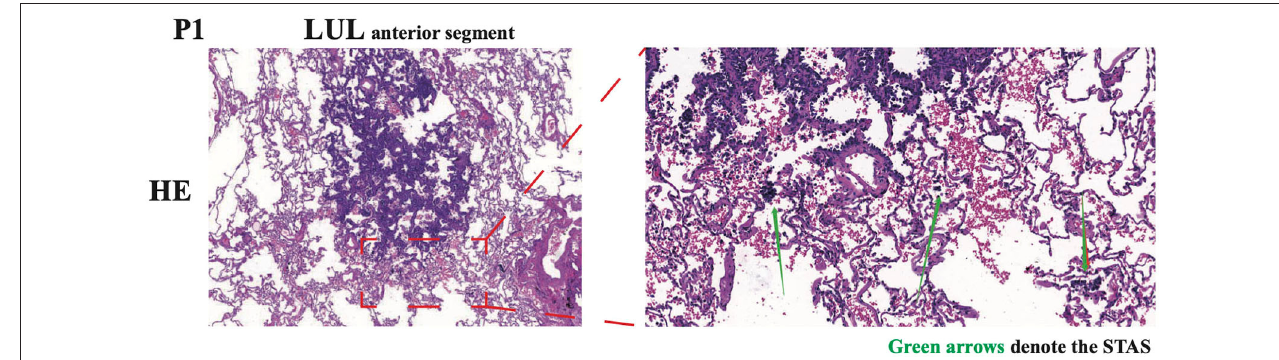
FIGURE 2 | Representative images of HE immunohistochemical staining of N1 in P1. The spread through air spaces (STAS) of tumor cells was denoted by green arrows. LUL, left upper lobe.